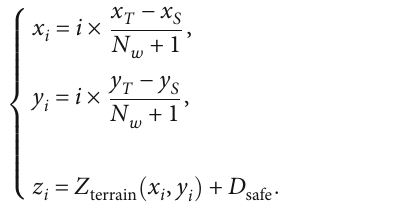
Table 1: The statistical results of three cases.